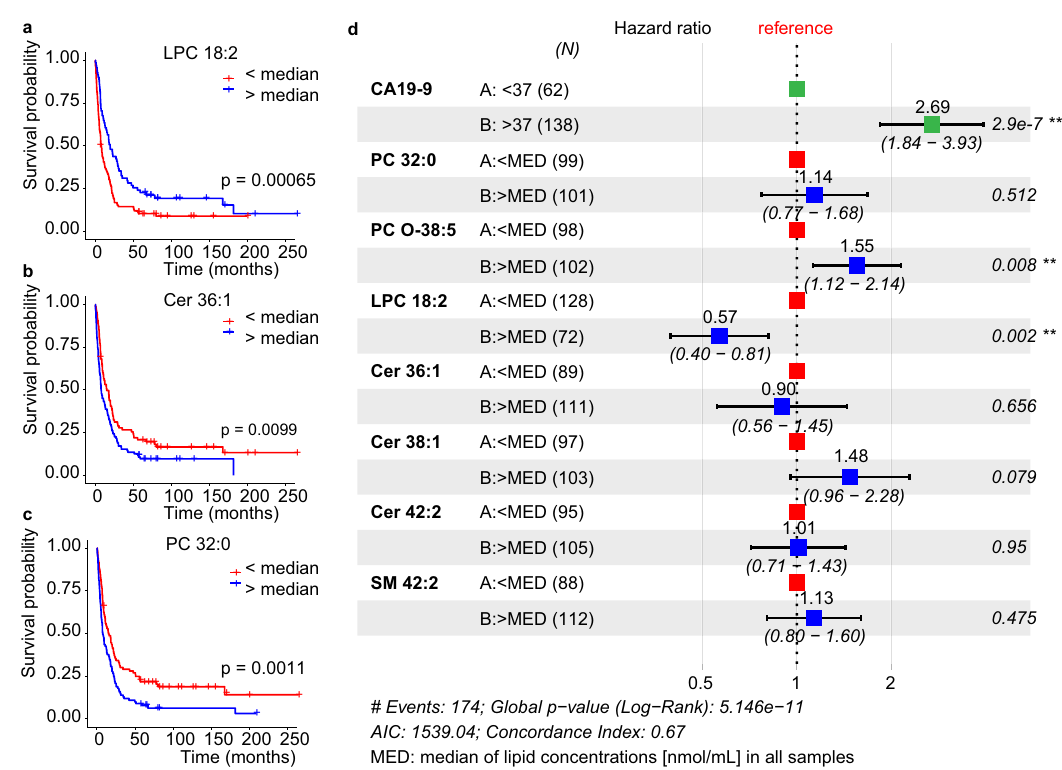
Fig. 9 Potential of selected lipids for the survival prognosis in Phase II measured by UHPSFC/MS. Kaplan – Meier Survival plots for: a LPC 18:2 ( n = 128 for binary code 0, and n = 72 for binary code 1), b Cer 36:1 ( n = 89 for 0, and n = 111 for 1), and c PC 32:0 ( n = 99 for 0, and n = 101 for 1) together with the two-sided log-rank test p -value. d Cox proportional-hazards model for CA 19-9, PC 32:0, PC O-38:5, LPC 18:2, Cer 36:1, Cer 38:1, Cer 42:2, and SM 42:2. The forest plot illustrates the 95% con fi dence intervals of the hazard ratios and the corresponding log rank test p values for every parameter are presented. Hazard ratios > 1 indicate poorer survival. Lipid species concentrations normalized to the NIST reference material obtained for all samples in Phase II were converted into the binary code, whereby 0 was set for c < median and 1 for c > median (the median of concentrations was calculated for each lipid species including all samples). Source data are provided as a Source Data fi